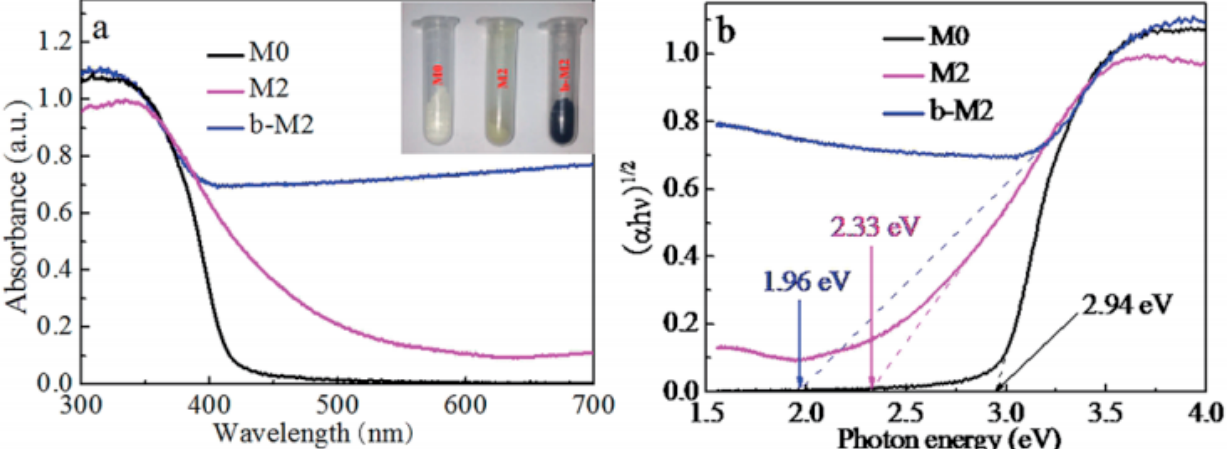
Figure 8. ( a ) UV-vis absorption spectra of TiO 2 (M0), Ni-doped TiO 2 (M2), and black Ni-TiO 2 (b-M2); ( b ) band gap for M0, M2, and b-M2 samples, respectively. Reprinted with permission for ref. [95]. Copyright 2015, The Royal Society of Chemistry.